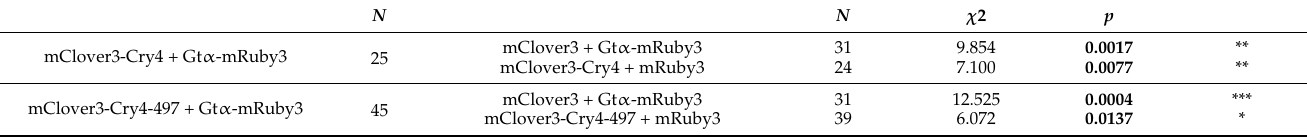
Table 2. Statistics of FRET monitoring. ANOVA results of the binomial GLM for differences between the interactions Cry4 and Cry4-497 with Gt α and the respective negative controls with mRuby3 or mClover3 only. The respective sample sizes ( N ), resulting chi-squared statistics ( χ 2) and p -values are listed for each comparison. Significant differences are indicated with asterisks, corresponding p -values are in bold ( p ≤ 0.05 = *; p ≤ 0.01 = **; p ≤ 0.001 = ***. N N χ